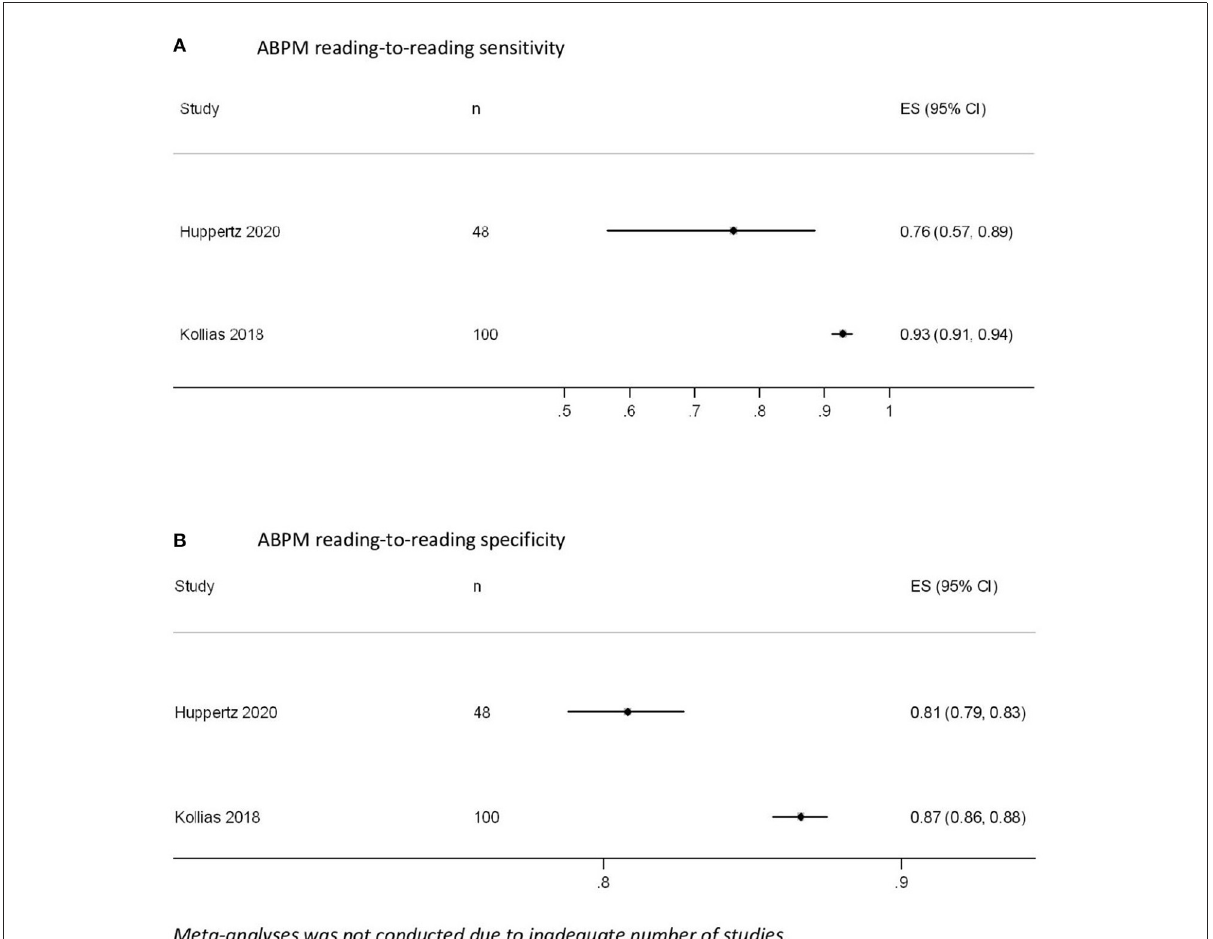
FIGURE4 Ambulatory blood pressure measurement (ABPM) reading-to-reading (A) sensitivity and (B)